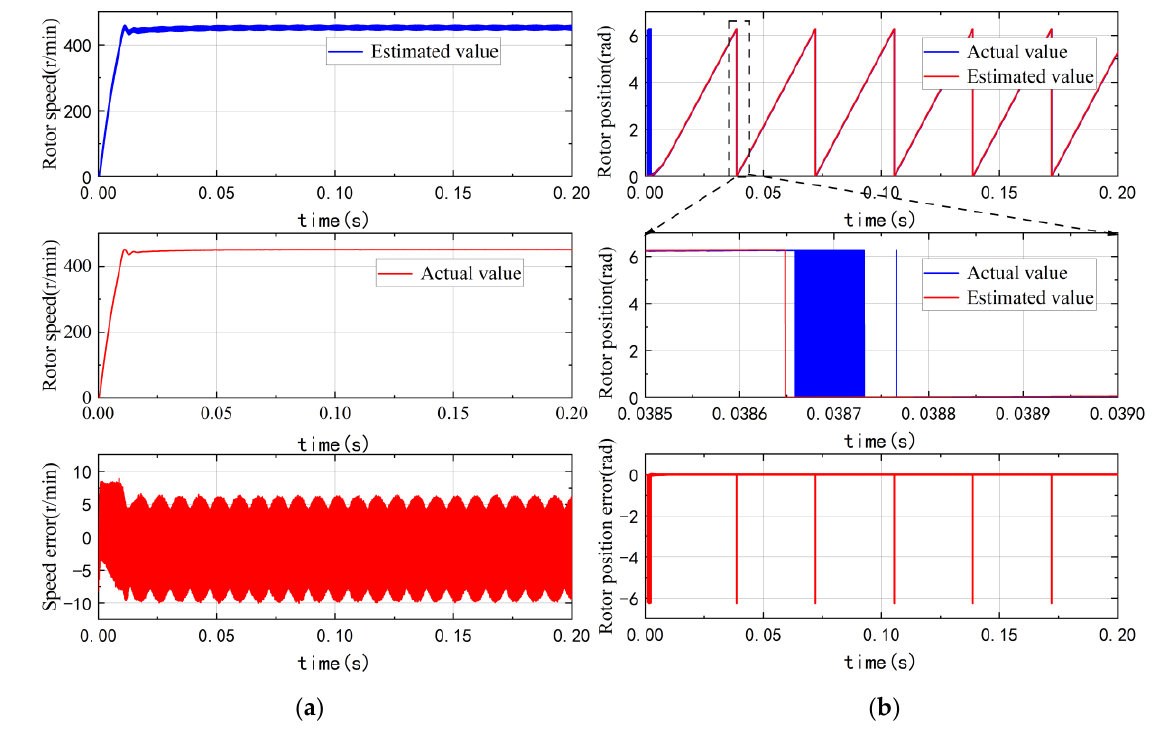
Figure 13. Speed and position estimation results of traditional SMO at low speed: ( a ) rotor speed;